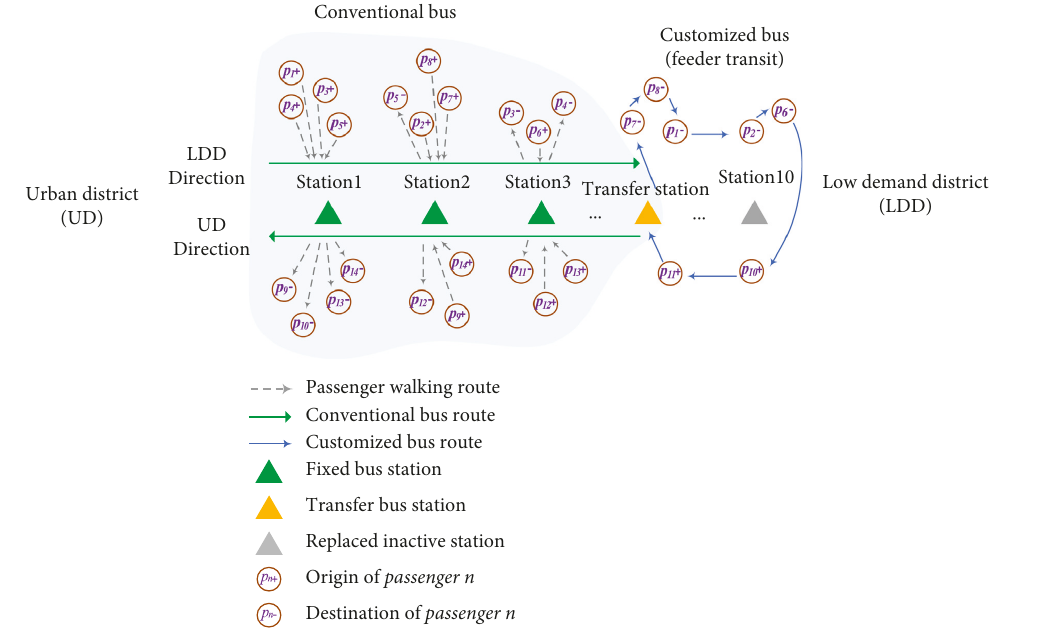
Figure 2: Integrated operation mode I customized buses (feeder transit) and conventional